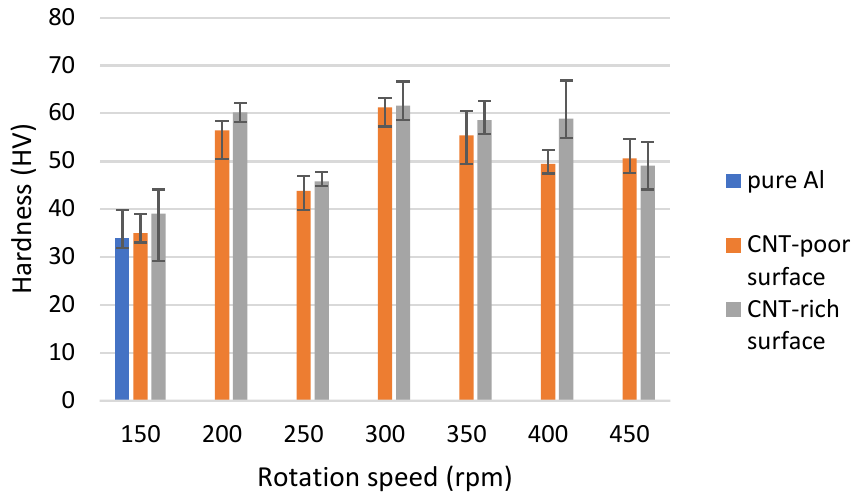
Figure 8. Vickers hardness on the CNT-rich and CNT-poor surfaces for samples with various rotation speeds. As a reference, data for pure Al is also shown.